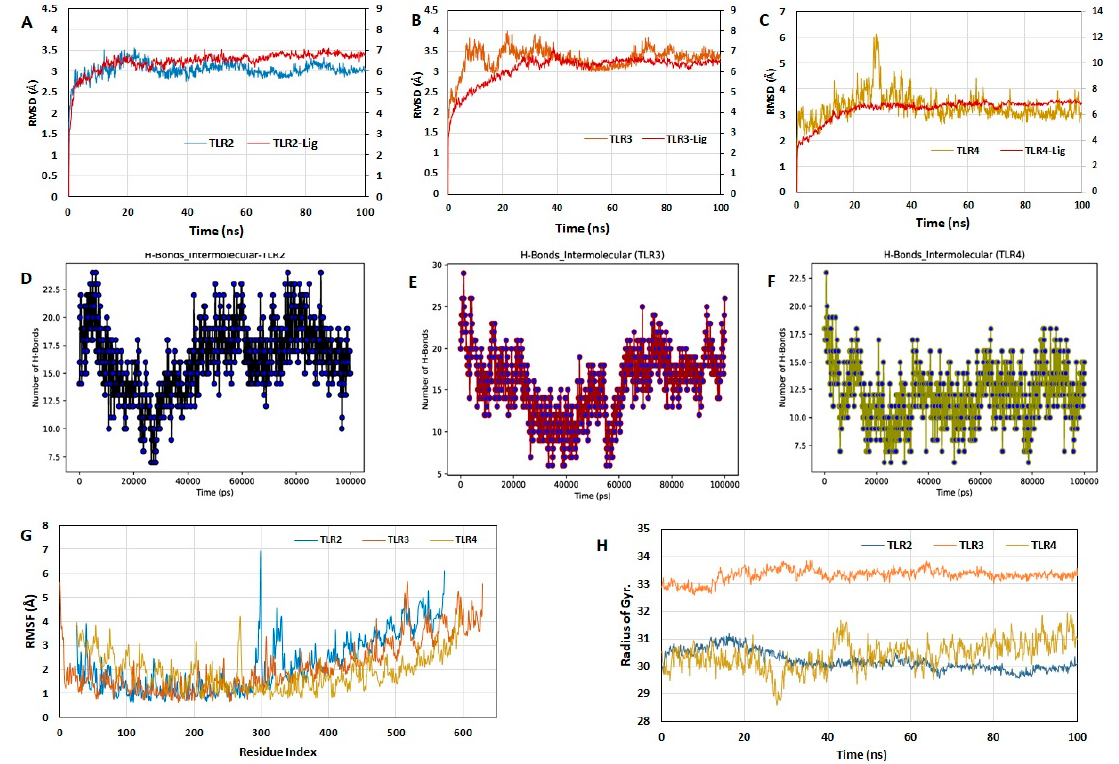
Figure 7. Molecular dynamics simulation of vaccine and immune receptors. ( A – C ) RMSD plot of docked vaccine construct with TLR2, TLR3 and TLR4 receptors respectively. ( D – F ) Intermolecular H-bonds of docked vaccine construct with TLR2, TLR3 and TLR4 receptors respectively. ( G ) RMSF plot of TLR2, TLR3 and TLR4 receptors. ( H ) Radius of gyration of TLR2, TLR3 and TLR4 receptors.